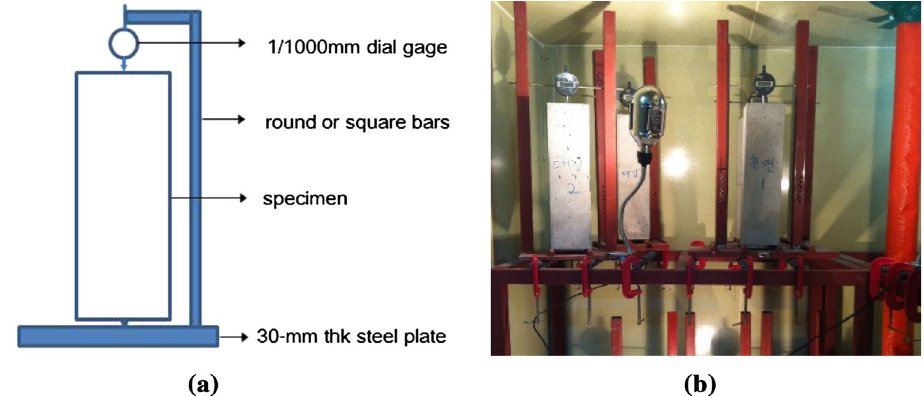
Fig. 4 Experimental specimens with a dial-gauge installed. a Schematic diagram, b